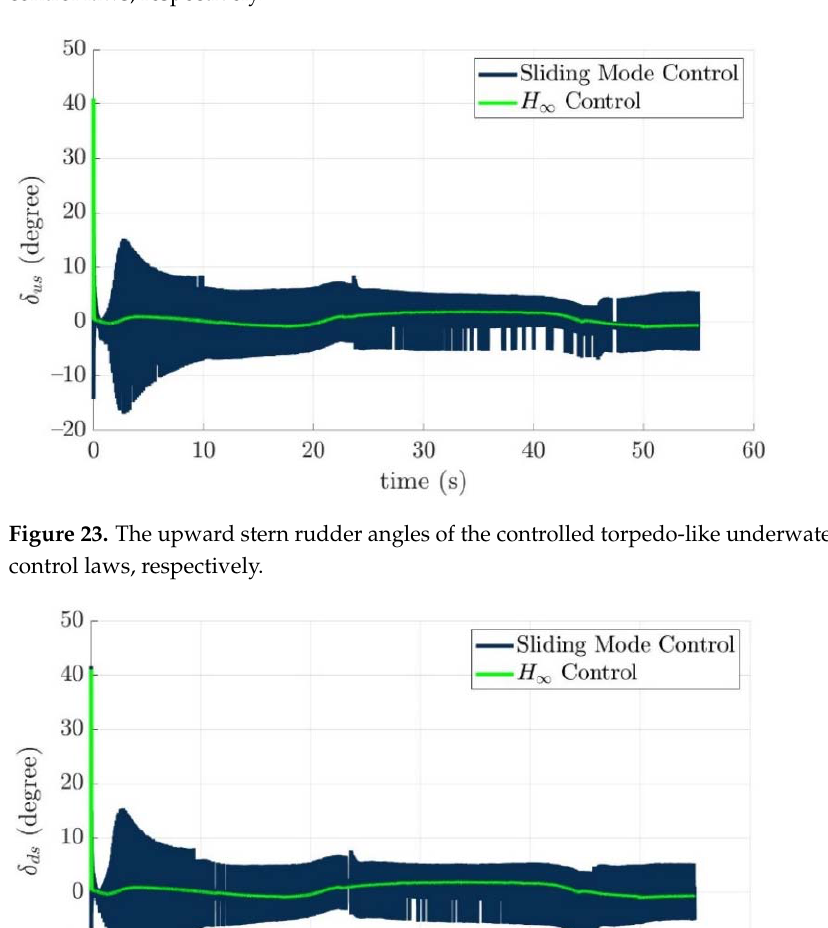
Figure 22. The starboard stern fin angles of the controlled torpedo-like underwater vehicle for two control laws, respectively.